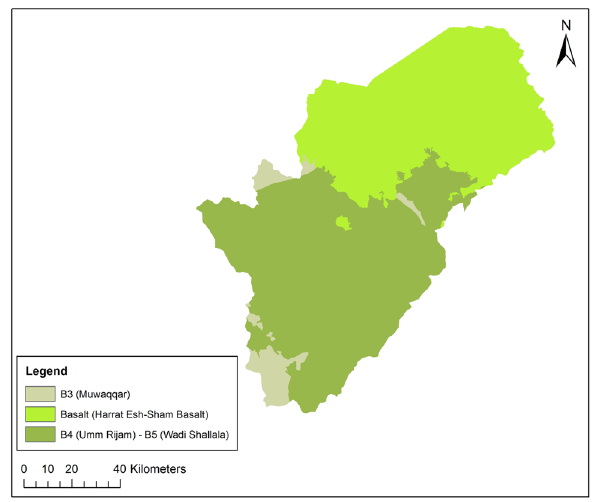
Table 6 Parameters used in SWAT model